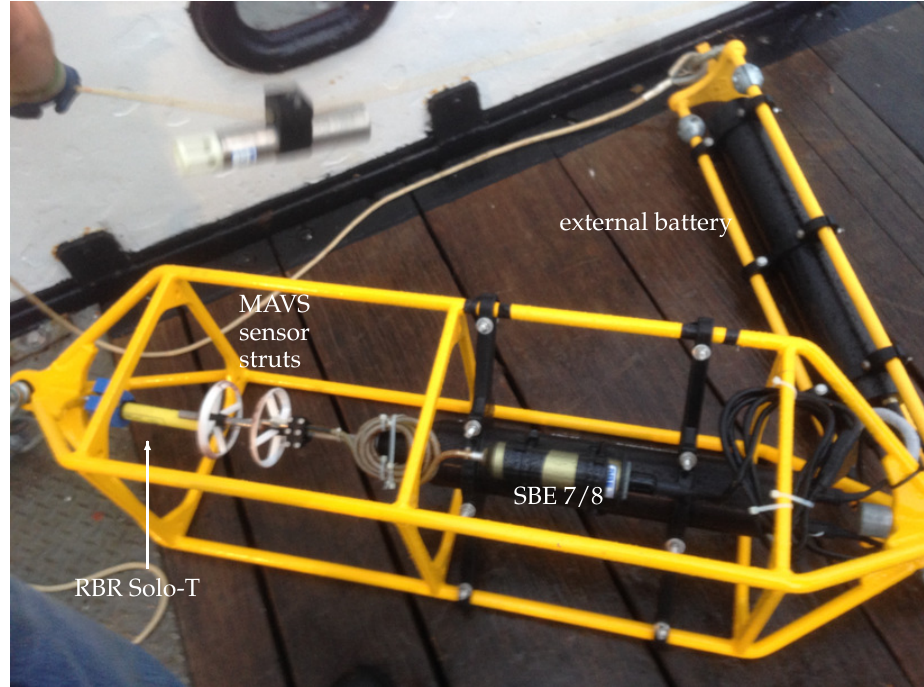
Figure 1. Picture of the enhanced MAVS immediately after recovery. The RBR SoloT temperature sensor is the yellow sensor to the left, the white rings hold the transducer pairs for the MAVS, and the metallic green cylinder is the pressure case for either the SBE-7 or SBE-8 microstructure sensor